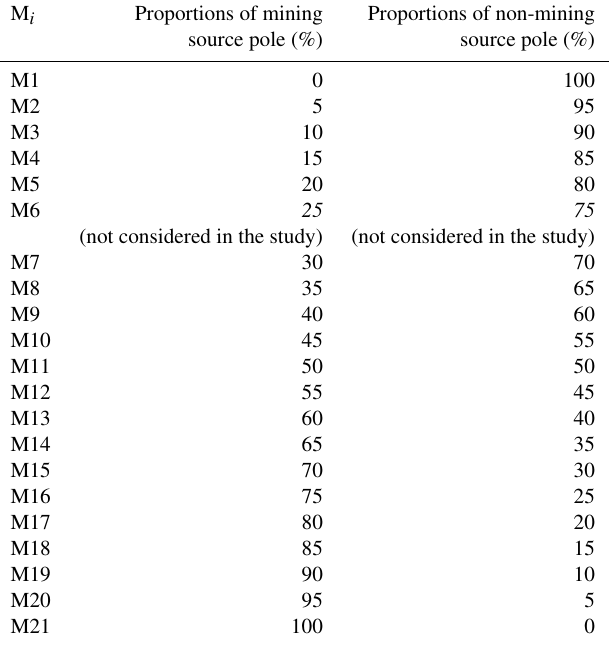
Table 1. Proportions of mining and non-mining sources (%) in ar- tificial mixture samples (M i ). M6 was withdrawn from this study because an error occurred at the time of its completion (not consid- ered in the study, given in